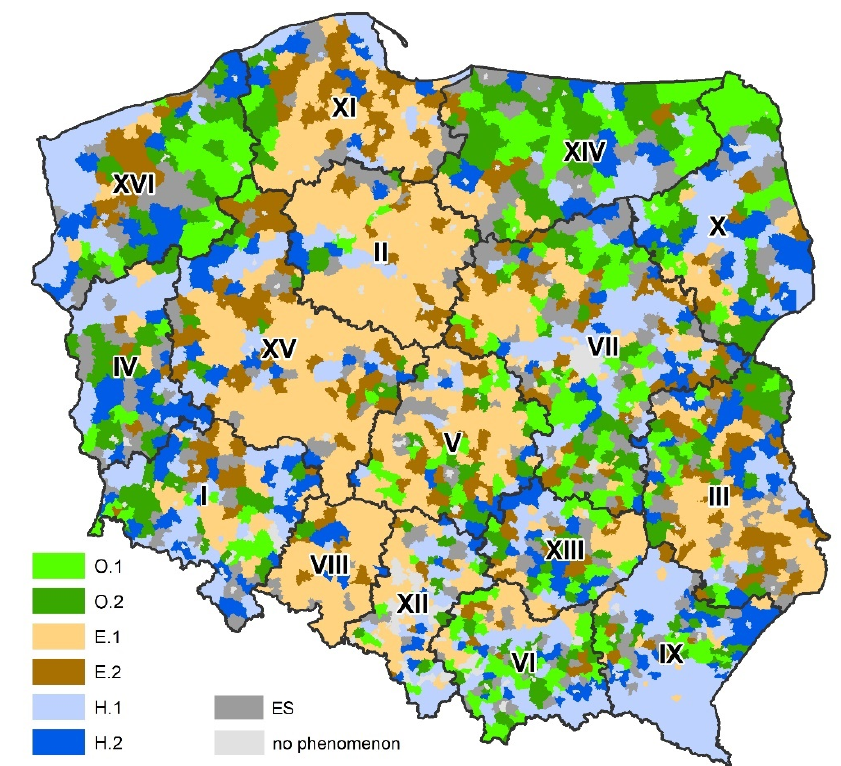
Figure 7. Structural types of farmland covered by pro-environmental CAP measures. Source: own elaboration.